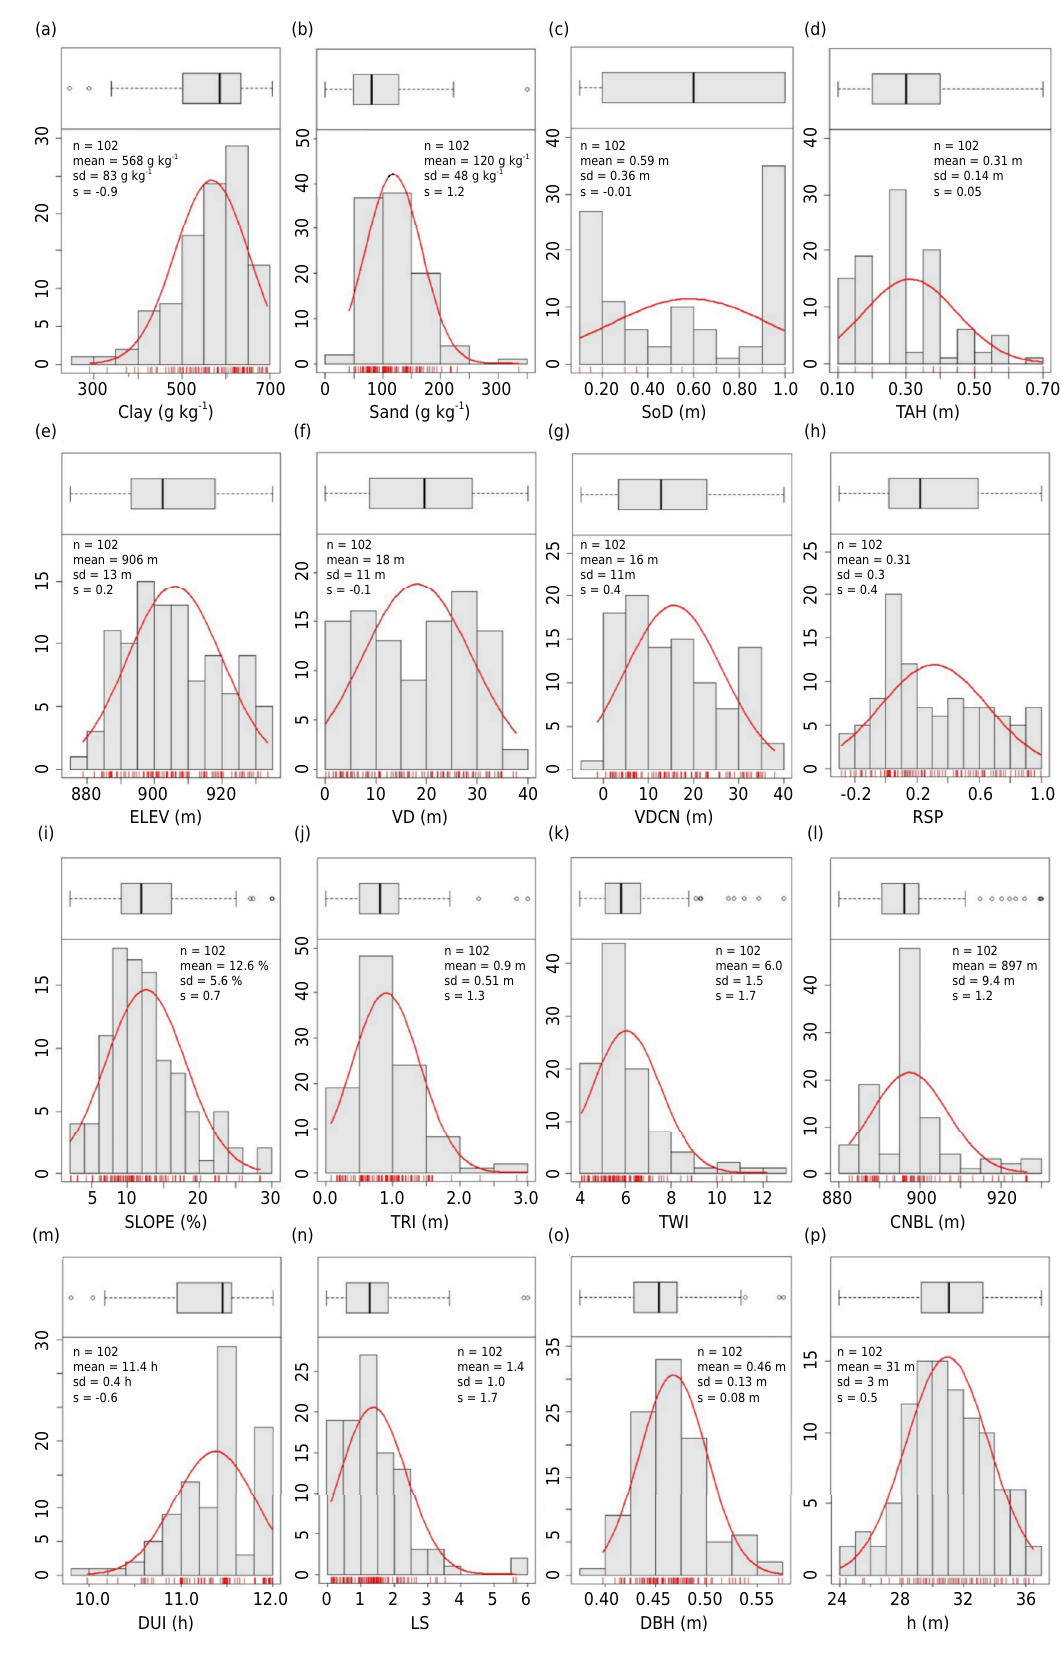
Figure 3. Descriptive statistics of dendrometric, topographic, and pedological variables of dataset 2, in which the statistical variables are: n: number of samples; m: mean; sd: standard deviation; s: skewness. Pedological variables are: (a) clay; (b) sand; (c) solum depth (SoD); (d) thickness of A horizon (TAH). Topographic variables are: (e) elevation (ELEV); (f) valley depth (VD); (g) vertical distance to channel network (VDCN); (h) relative slope position (RSP); (i) slope; (j) terrain ruggedness index (TRI); (k) topographic wetness index (TWI); (l) channel network base level (CNBL); (m) duration of insolation (DUI); (n) LS factor (LS). Dendrometric variables are: (o) diameter at breast height (DBH); (p) total tree height